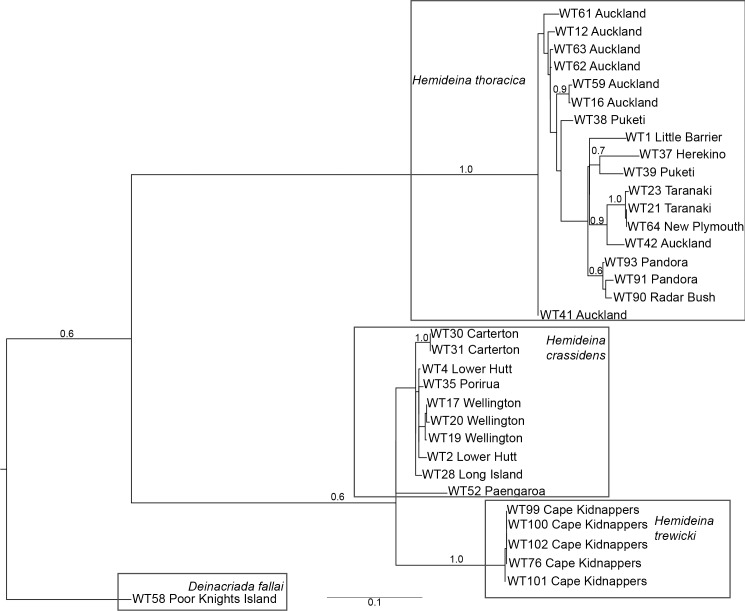
Maximum likelihood phylogeny constructed using mitochondrial cytochrome oxidase subunit I (COI) DNA sequences from individuals representing three Hemideina and one Deinacrida species.Bootstrap support values greater than 0.5 are indicated. Scale bar represents the number of substitutions per site.